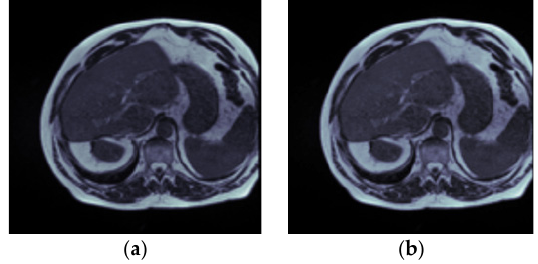
Figure 4. Filtering: ( a ) Input Image & ( b ) Filtered Image.